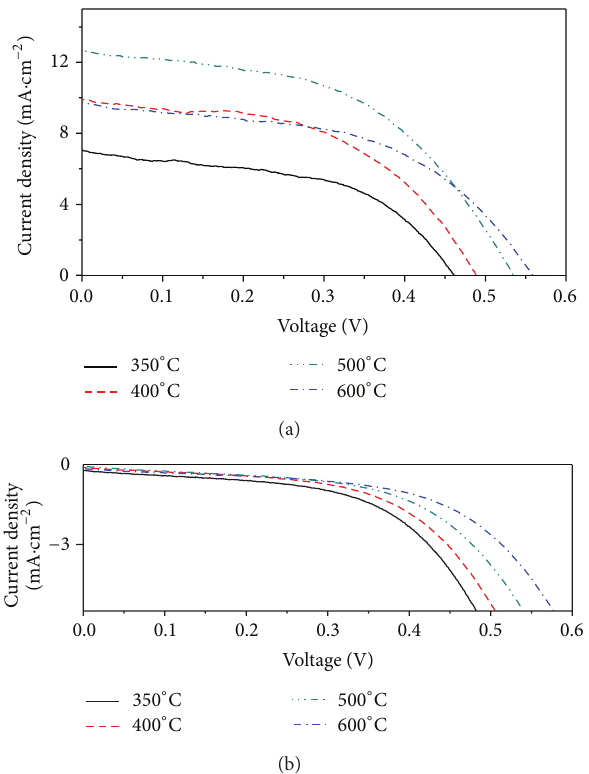
Figure 2: J-V characteristics of devices when TiO 2 shell was annealed between 350 and 600 ∘ C (a) under AM 1.5 illumination and (b) at dark condition.